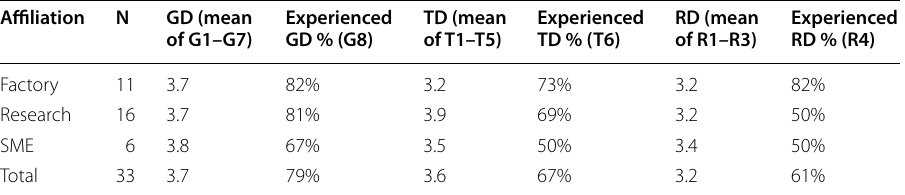
Table 1 Summary of the survey